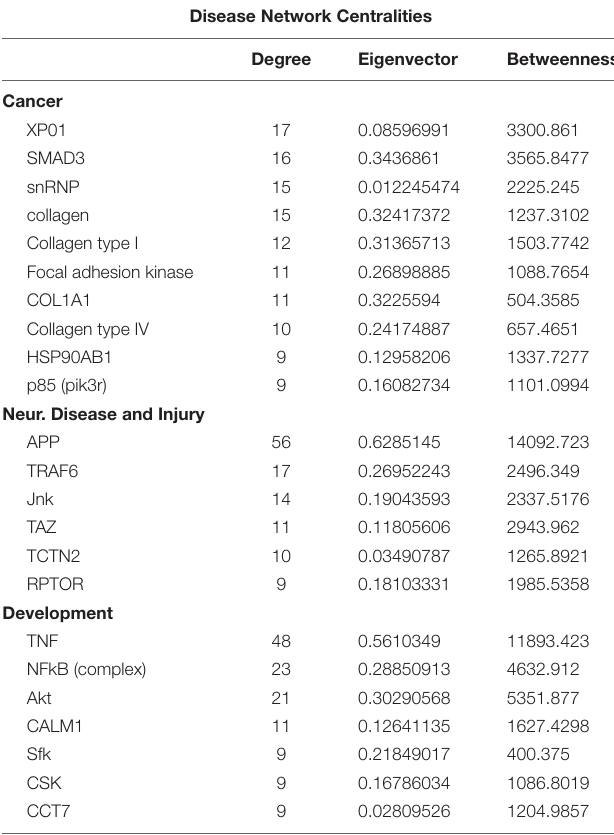
TABLE 2 | Centrality values of differentially regulated